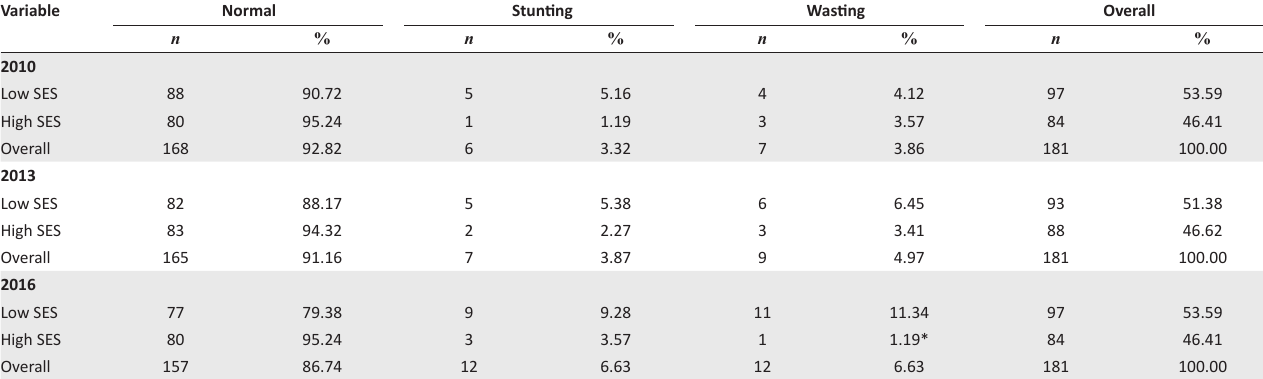
TABLE 3: The relationship between socio-economic status, stunting and wasting over 7 years.